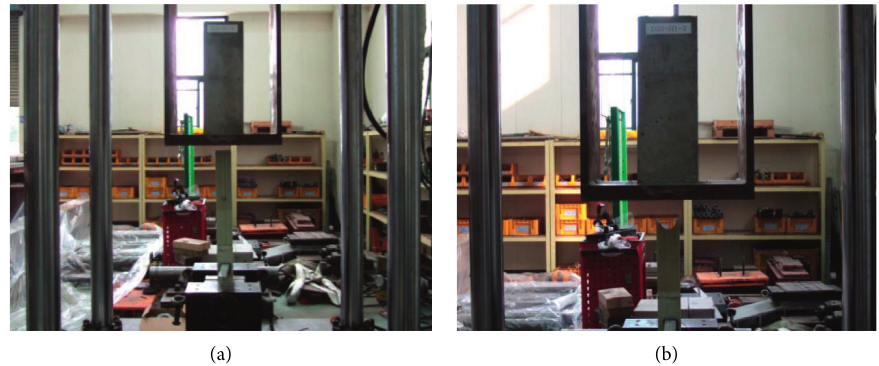
Figure 28: Two different failure modes in the pullout test: (a) concrete failure; (b) FRP rapture.